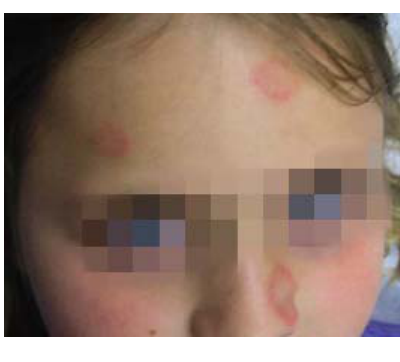
Figure 17. Tinea